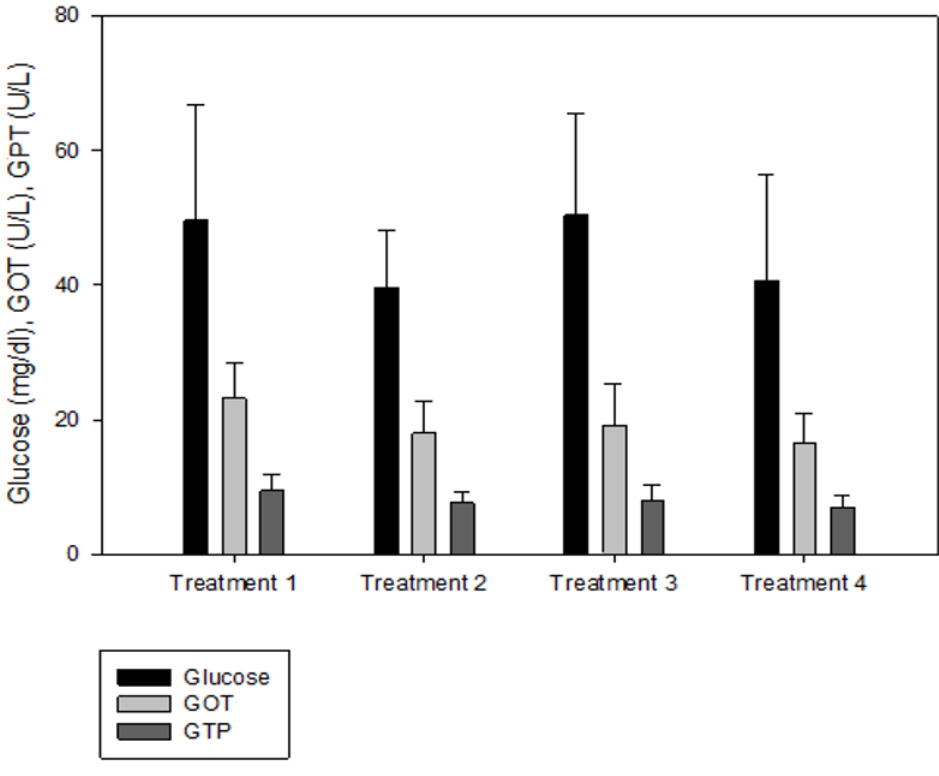
Figure 4. Glucose, glutamic oxaloacetic transaminase (GOT), and glutamic pyruvic transaminase (GPT) levels of olive flounder Paralichthys olivaceus cultured at four different initial stocking densities. The data are presented as mean ± standard deviation.